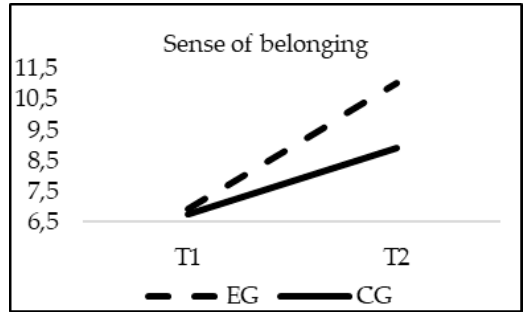
Figure 6. Interaction effects of group (EG-CG) and time (T1-T2) in Satisfaction.